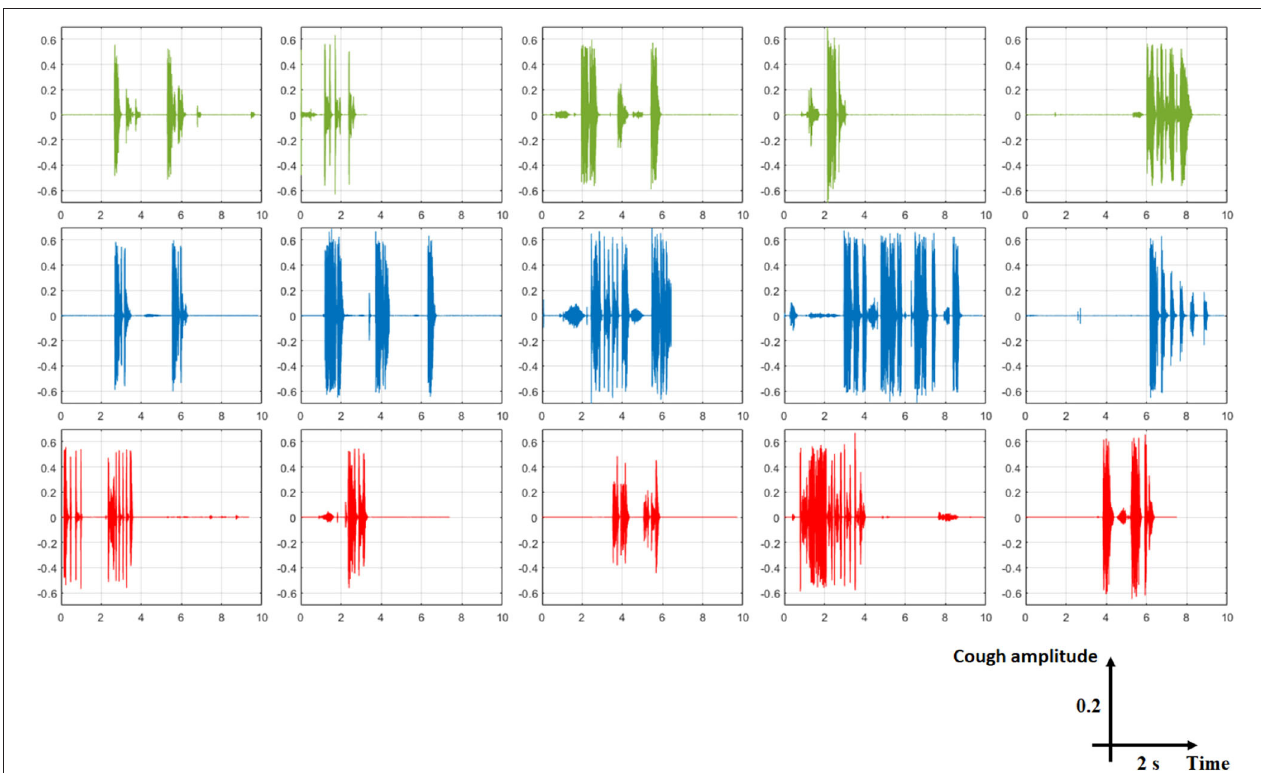
FIGURE 7 | Representative examples of some cough types from COUGHVID database. Each signal has a total duration of 10 s. The five first signals in green color are from healthy subjects, the blue ones are from symptomatic subjects, and the red ones are from COVID-19 subjects. From this figure, it is clear that detecting cough sounds, to be distinguished from noise or speech, is an important step before classifying expert-labeled cough